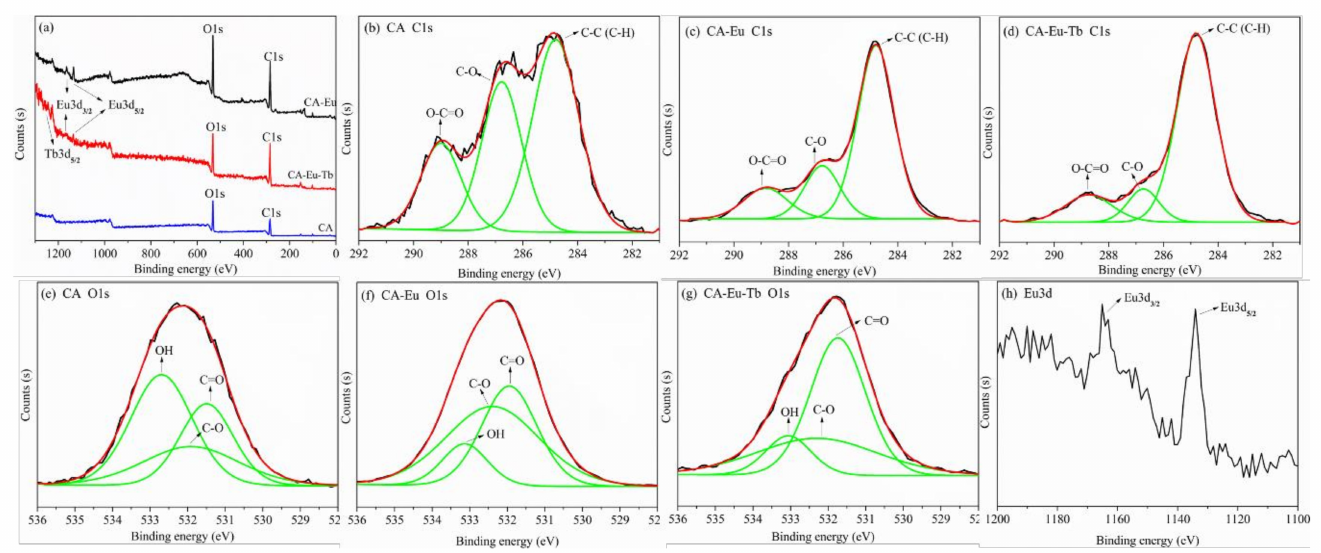
Figure 2. The XPS spectra of CA, CA–Eu and CA–Eu–Tb films. ( a )—the survey spectrum, ( b )—the C1s spectra for CA, ( c )—CA–Eu, ( d )—CA–Eu–Tb; ( e )—the O1s spectra for CA, ( f )—CA–Eu, ( g )—CA–Eu–Tb, ( h )—the Eu3d spectra.